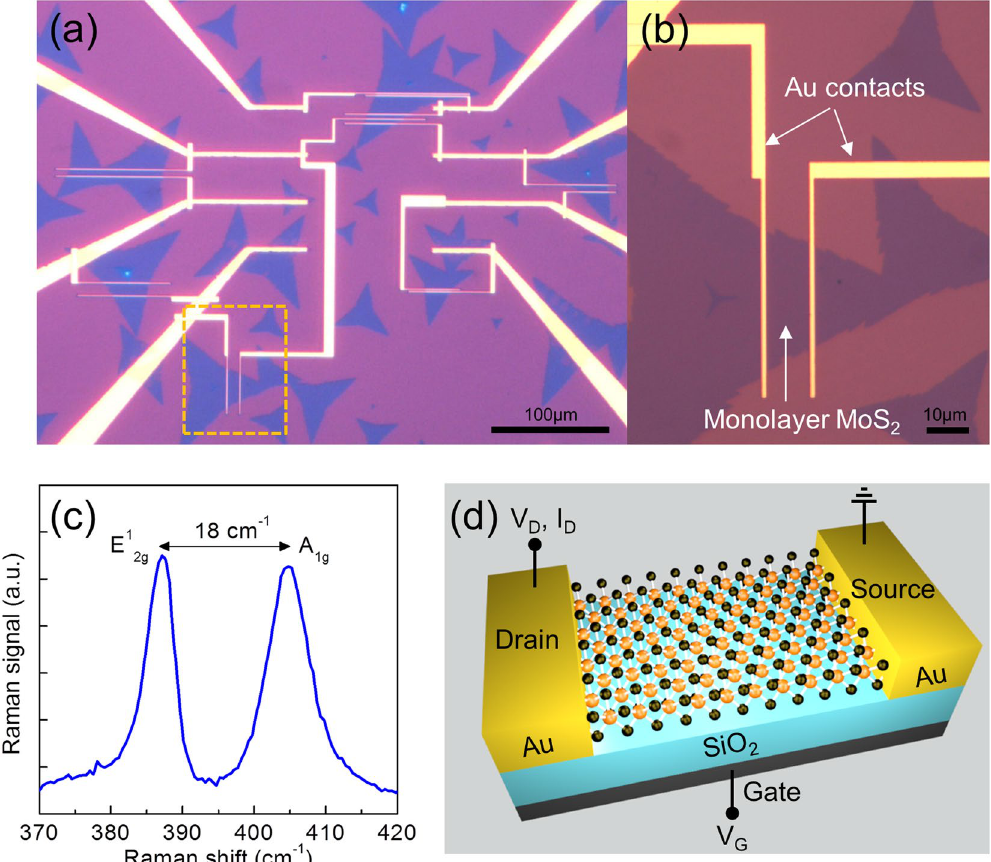
Figure 1. Fabrication of CVD-grown monolayer MoS 2 FETs. ( a,b ) Optical images of the monolayer MoS 2 FETs. The magnified view in ( b ) shows a monolayer MoS 2 flake with Au contacts on top. ( c ) Raman spectrum of the monolayer MoS 2 flake with a peak spacing of 18 cm − 1 between the E 1 2g and A 1g vibrational modes, confirming the monolayer nature of the CVD-grown MoS 228 . ( d ) Three-dimensional schematic of the monolayer MoS 2 FET with measurement configuration. The monolayer MoS 2 flake is placed on a heavily doped p-type silicon substrate with a 285 nm-thick SiO 2 layer for back-gate